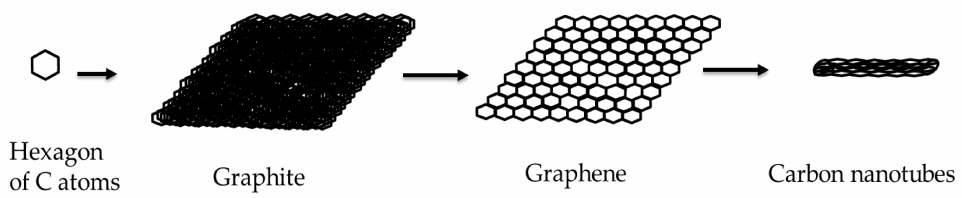
Figure 2. Forms of carbon materials; 3-D graphite, 2-D graphene and 1-D nanotube.